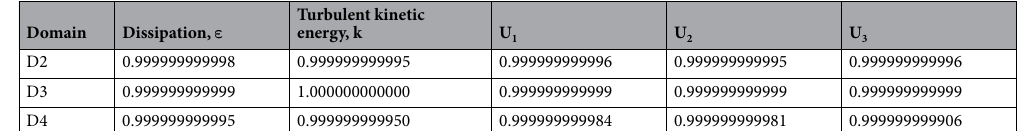
β α U , β α U ) for Domains 2–4 at the 64000 1 U 2 U 3 U